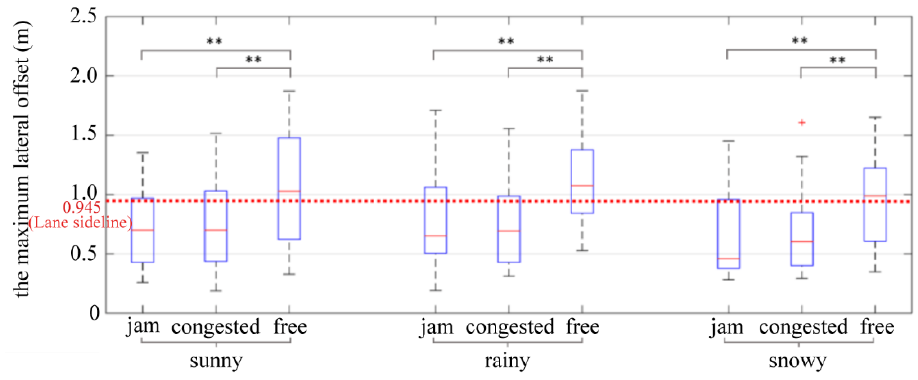
Figure 15. The maximum lateral offset. ** indicates the variable was statistically significant at 0.05 level. + indicates outlier.